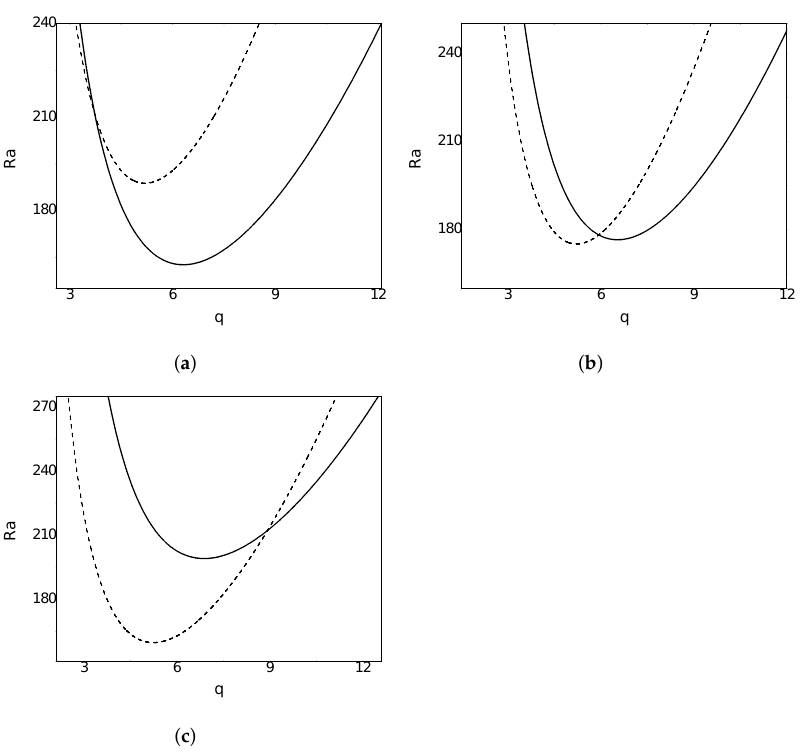
Figure 5. Neutral curves (solid lines represent the stationary convection and dotted lines represent the oscillatory convection) for Dm = 20, Ta = 3.1, Va = 20: ( a ) Ha = 0.5, ( b ) Ha = 0.6, ( c ) Ha = 0.7.